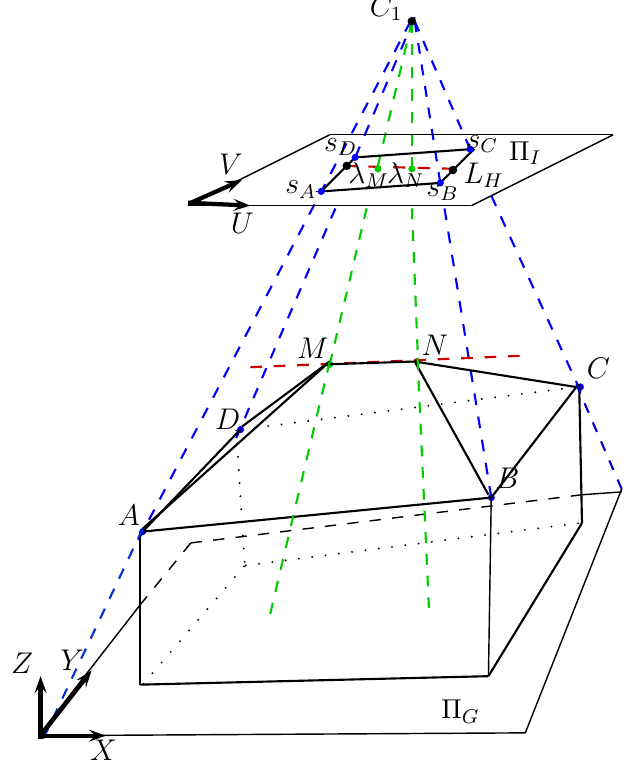
Figure 6. The adopted generic 3D polyhedral model. The multi-facet model ( i.e. , deformable model) is parameterized by Equation (3). s vertices selected in the image plane Π coordinates of the inner vertices M and N (unknown) along the detected Hough line L C 1 corresponds to the center of projection of camera 1. Blue and green lines are outer and inner lines of sight (perspective lines), respectively. Π geo-referenced world coordinate